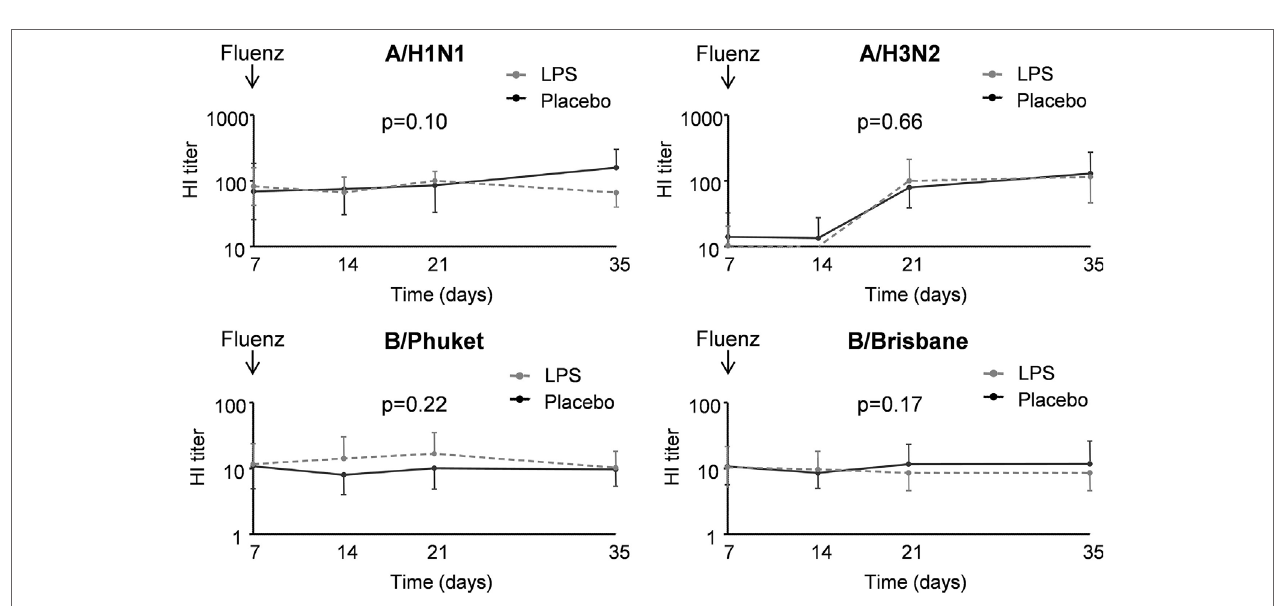
FigUre 9 | IgG titers for the different influenza strains in 26 subjects who were challenged with lipopolysaccharide (LPS) ( n = 13) or placebo ( n = 13) on day 0 and displayed infectivity after inoculation with Fluenz on day 7. Data are represented as geometric mean with 95%